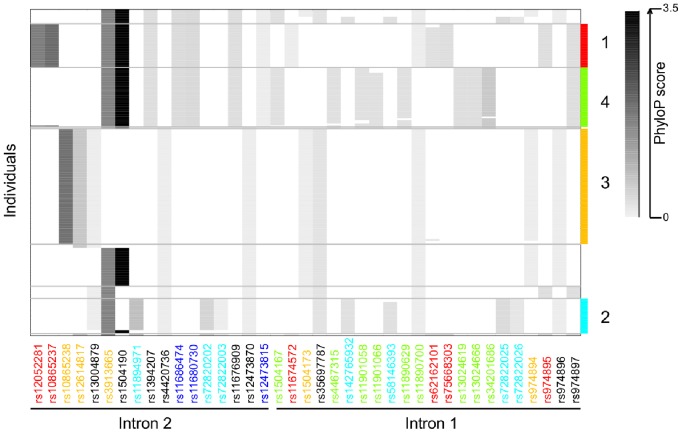
Haplotype structure of common SNPs within the fine-mapped interval.Each row corresponds to a phased chromosome from 93 Finnish individuals in the 1000 Genomes Project. Each column represents one of the 39 SNPs that are segregating in the sequenced regions and also in the fine-mapped interval spanning intron 1 and 2. Derived alleles at conserved sites are shown in gray scale with black being the most highly conserved sites by PhyloP and white showing the ancestral allele. The four major haplotypes are numbered and color coded on the right such that SNPs carried exclusively by one of the four haplotypes have the same label color on the bottom. The three tag SNPs evaluated in [16] are labeled in dark blue.